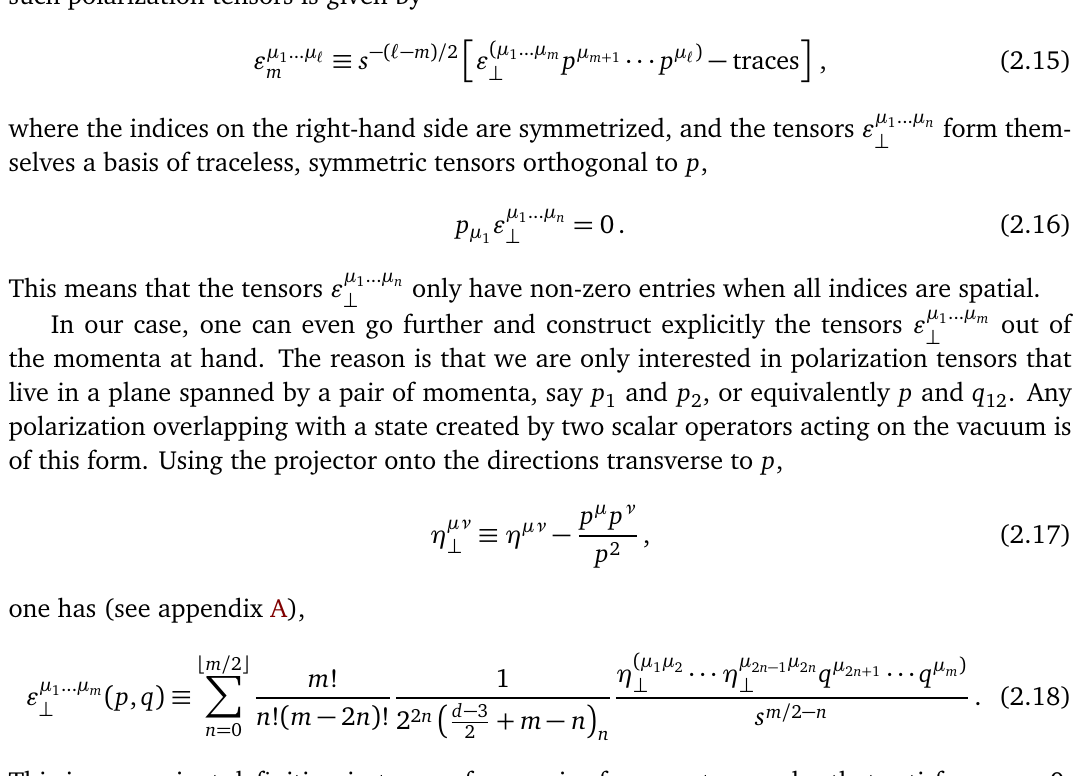
and 12 , p and 2 3